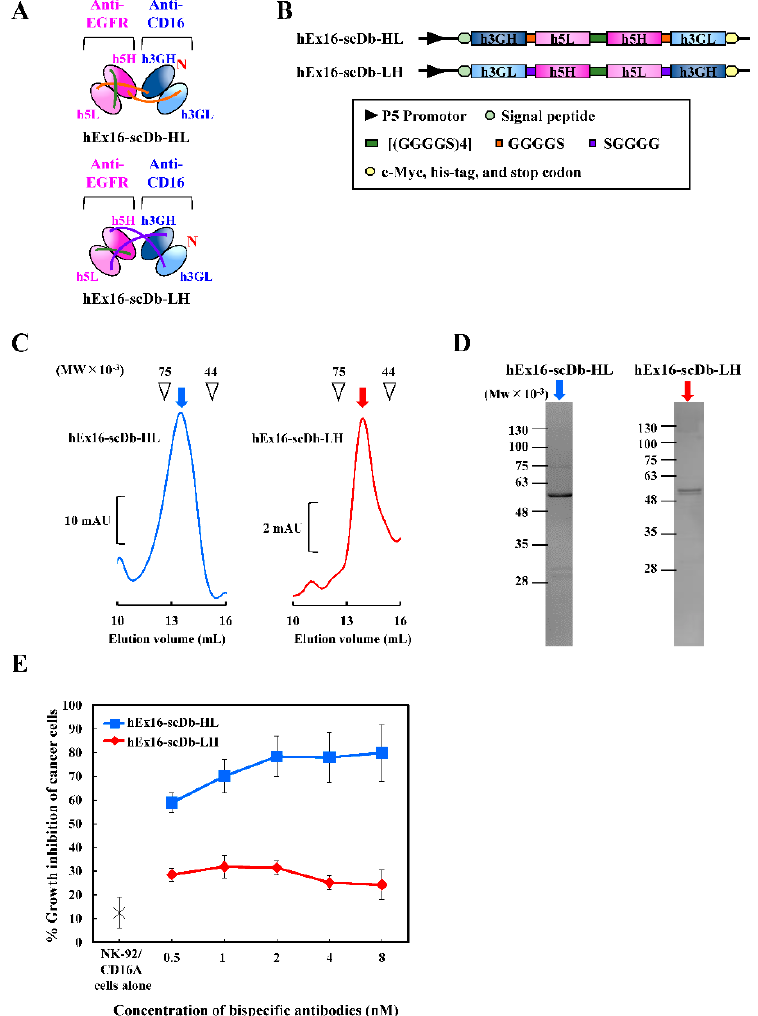
Figure 3. Preparation and evaluation of hEx16-scDbs with different domain orders. ( A ) Schematic diagrams of the two types of hEx16-scDbs: hEx16-scDb-HL and -LH. ( B ) Schematic diagrams of the vectors designed for the two types of hEx16-scDbs. ( C ) Gel filtration chromatographs of hEx16-scDbs and ( D ) SDS-PAGE analysis of monomer fractions indicated by arrows. mAU, milli-absorbance unit. ( E ) Growth inhibition of EGFR-positive TFK-1 cells by hEx16-scDbs. The purified hEx16-scDbs were added with the NK-92/CD16A cell line to TFK-1 cells. The ratio of TFK-1:NK-92/CD16A was 4:1.